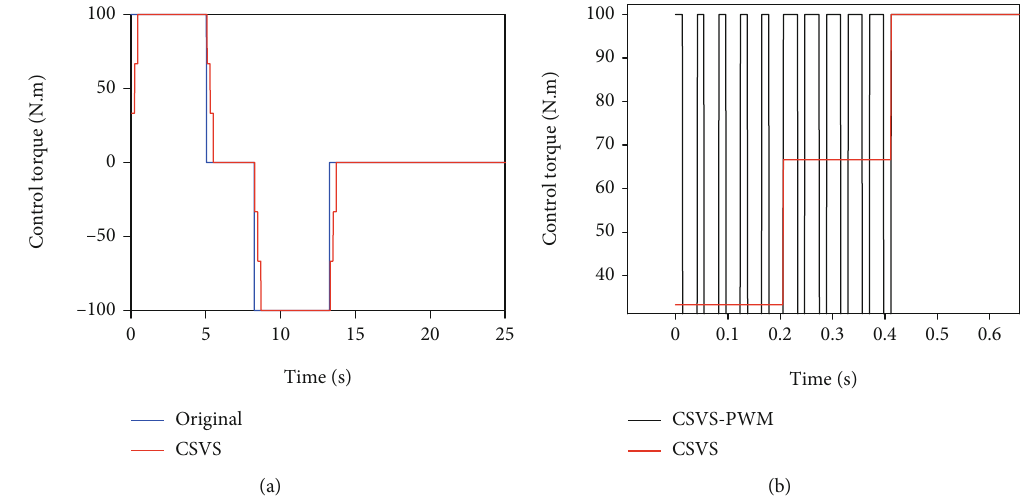
Figure 11: (a) CSVS command with zero-order robust and three components; (b) PWM transfer of CSVS